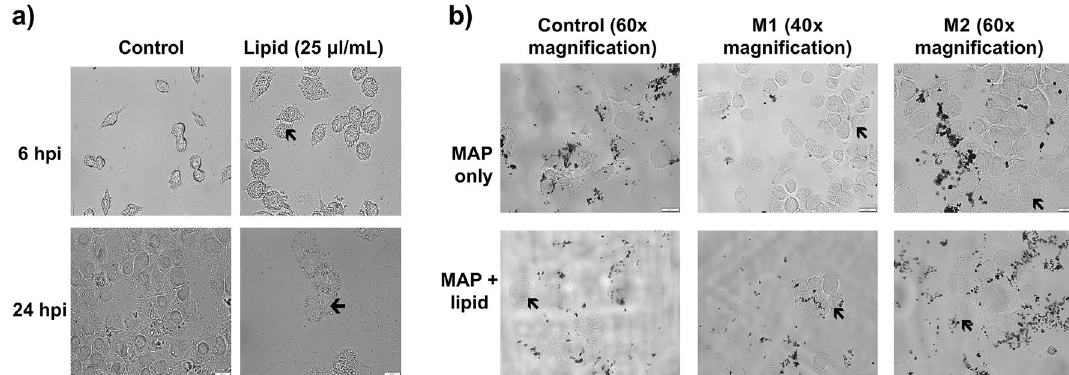
Figure 2. Lipid supplementation aids in the formation of foam cells and contributes to bacterial survival during MAP infection. ( a ) RAW264.7 macrophages were supplemented with exogenous lipid and imaged at 6 and 24 hpi. Lipid droplet formation within cells leading to foam cell formation (indicated by black arrows) were observed at both timepoints in macrophages supplemented with lipid. ( b ) Polarised RAW264.7 macrophages were infected with MAP and further supplemented with lipid prior to imaging at 6 hpi. Cells were heat fixed at 85 °C for 45 min prior to imaging, and all images acquired using an BX61 Olympus microscope. Scale bar represents 20 μm.